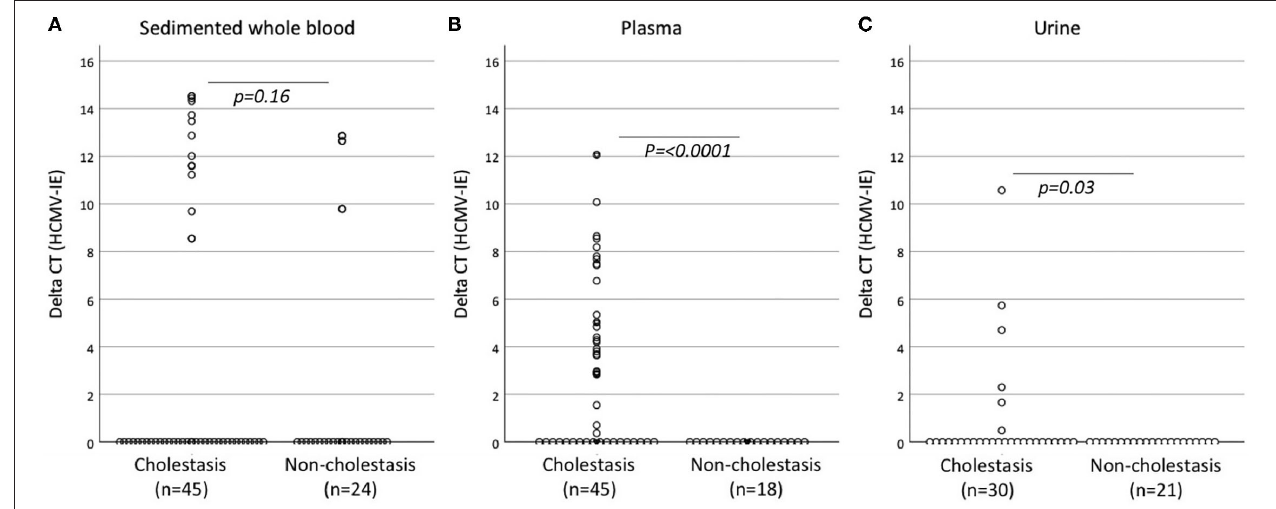
FIGURE 1 | Delta CT levels for CMV-IE DNA in samples from sedimented whole blood (A) , plasma (B) , and urine (C) from Taqman PCR assay. Mann–Whitney U -test was used as significance test for distributions. CT, cycle threshold; CMV-IE DNA, cytomegalovirus immediate early DNA.